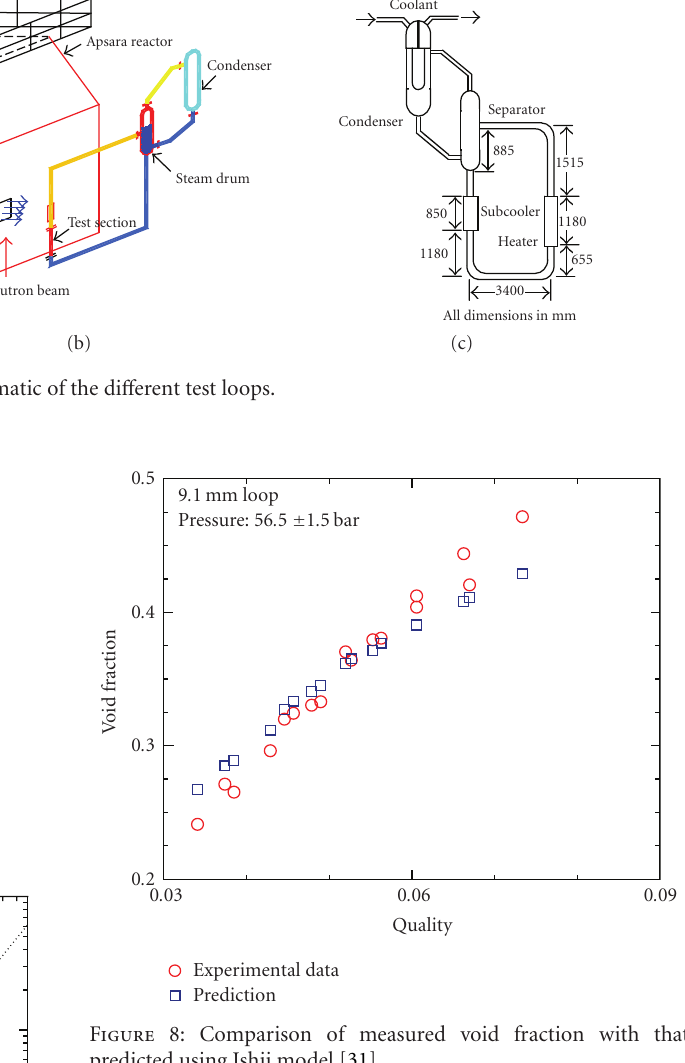
coe ffi cients β h and β T valid for two-phase and single-phase flows, respectively, may be noted. The constants C and r have the same definitions as in single-phase flow. The measured steady state flow rate data from the present test loops are plotted in Figure 9 in dimensionless form. The data are found to be within ± 40% of the above theoretical correlation from Figure